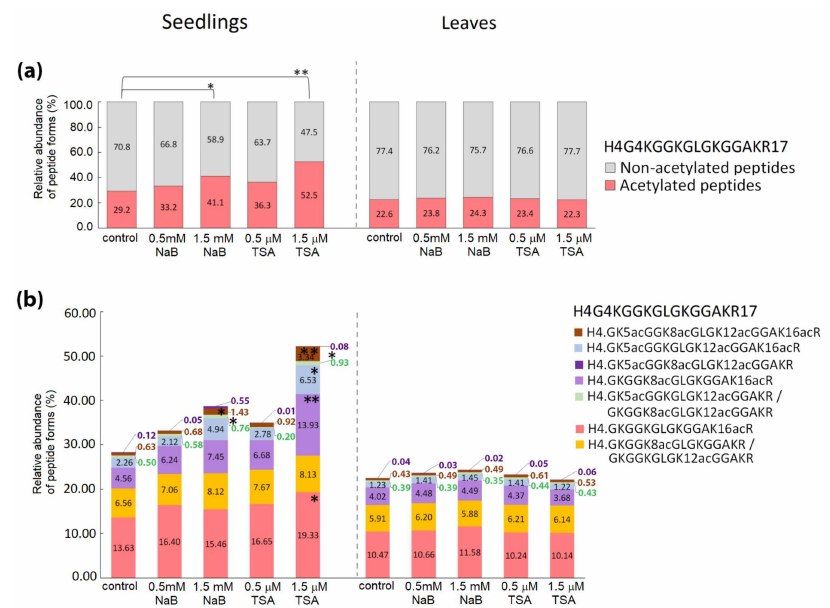
Figure 5. Relative abundance of peptide forms of histone H4 in seedlings germinated in the presence of HDA inhibitors, leaves of plants cultivated from these seedlings, and respective control samples. ( a ) The relative abundance of all peptide forms containing acetyl group(s) compared with that of peptides without acetylation. ( b ) The relative abundance of particular peptide forms containing acetyl group(s) compared with that of all other forms of respective peptide sequences. The levels of peptide forms were determined from the XIC peak areas. The significance of between-sample di ff erences was assessed using t-tests, setting the significance threshold at ** p < 0.01 and * p <